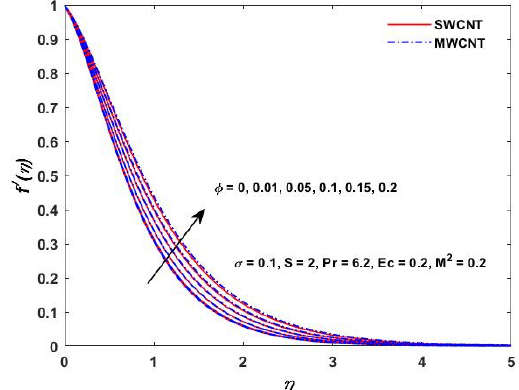
Figure 3. Magnetic parameter verses velocity 𝑔(𝜂).